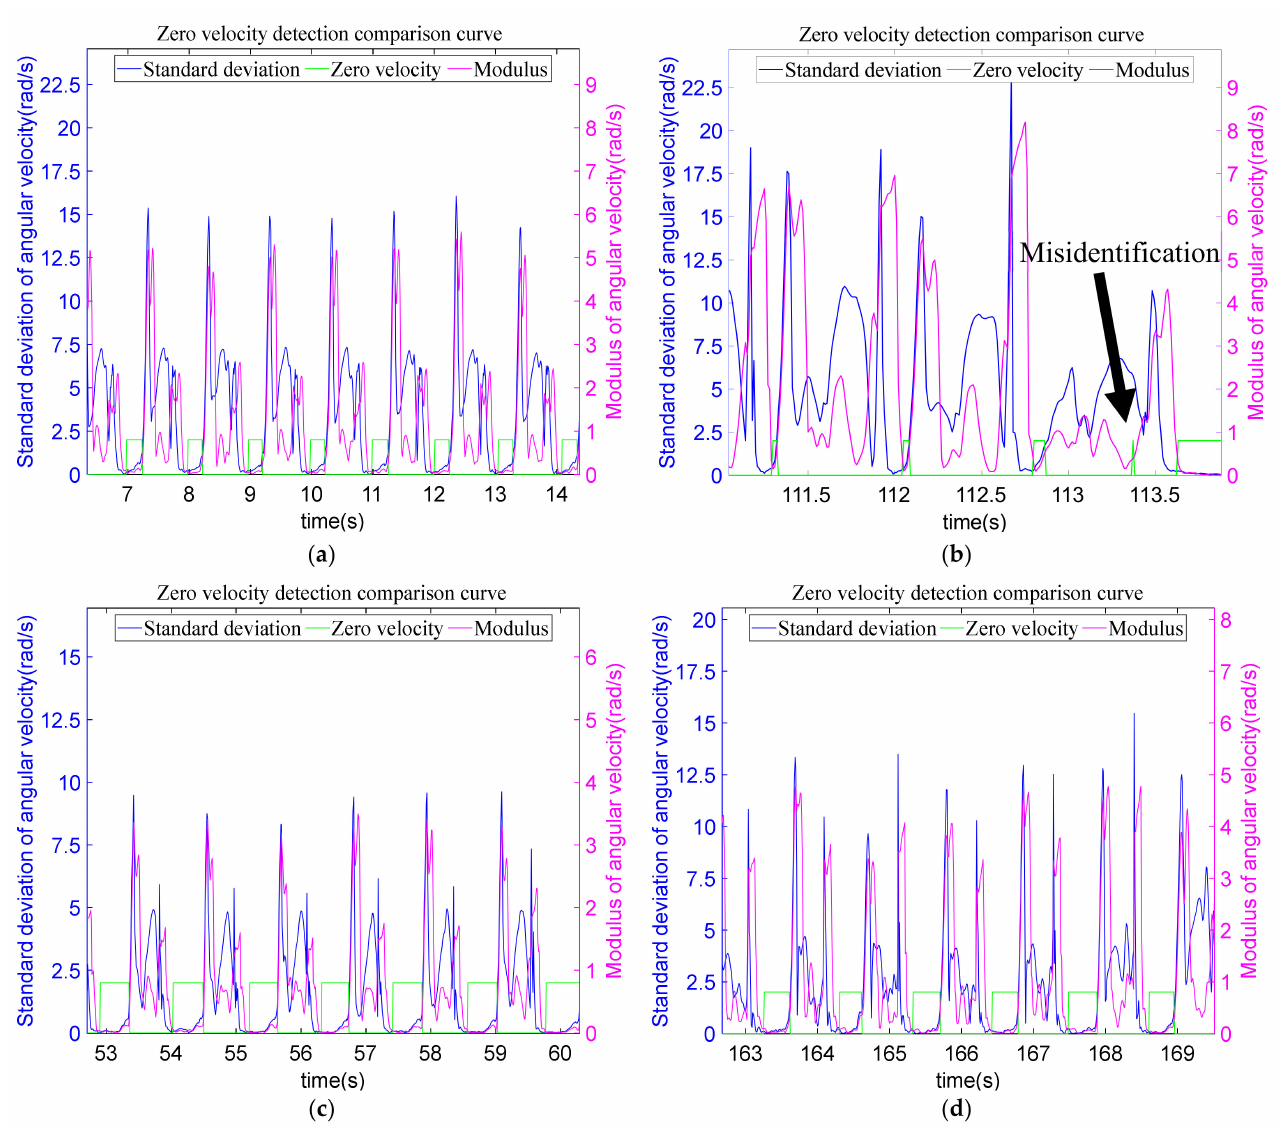
Figure 16. Detections of zero-velocity interval: ( a ) walking; ( b ) running; ( c ) going upstairs; and ( d ) going